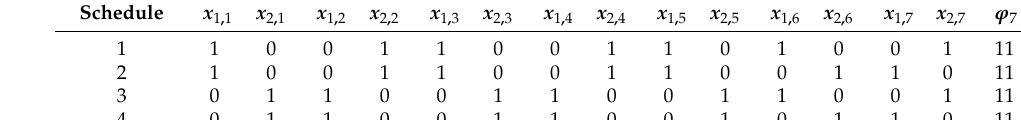
Table 4. Schedules with minimal makespan.